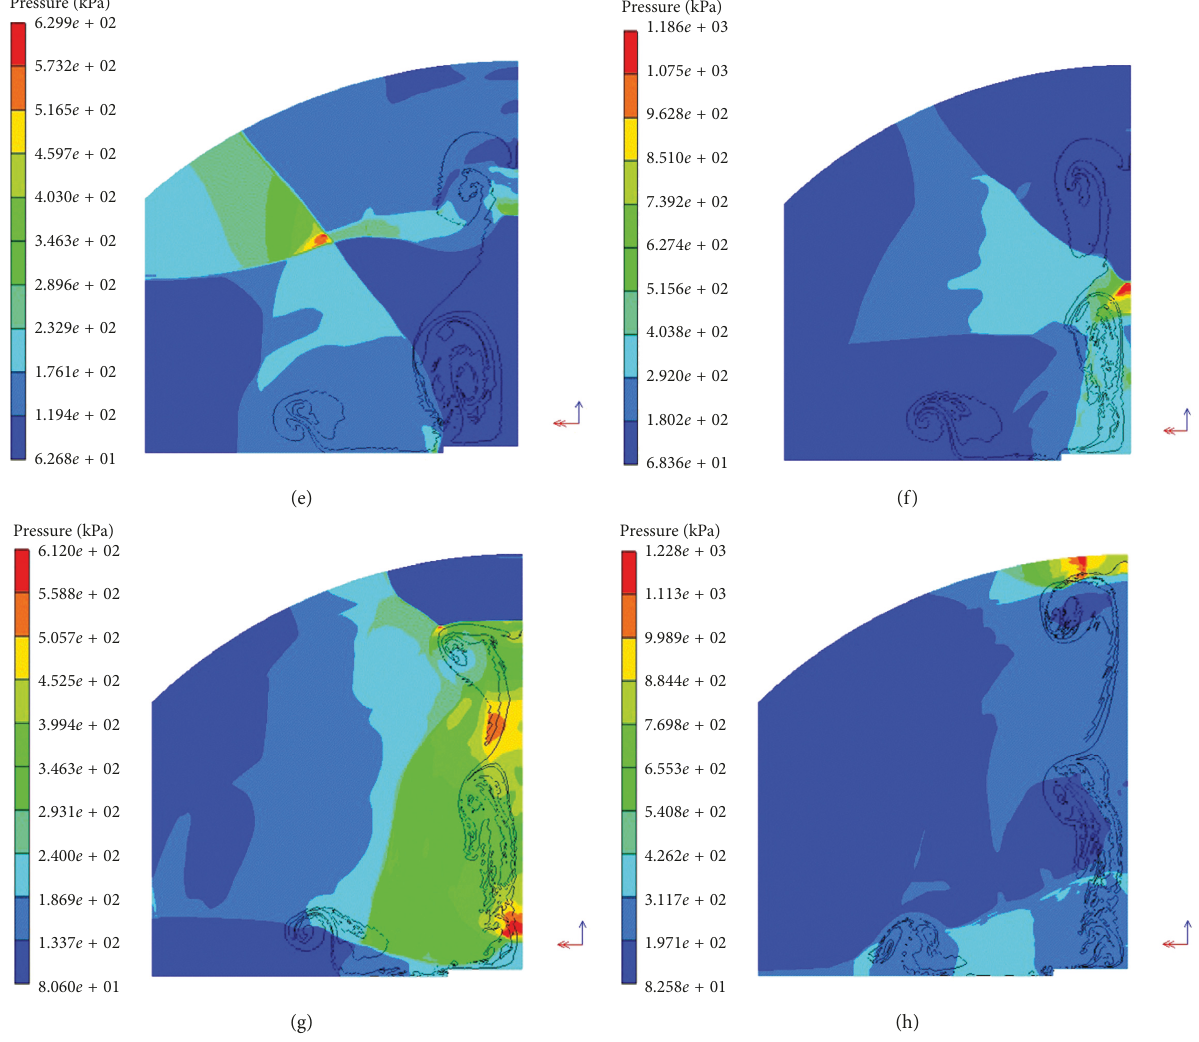
Figure 14: Evolution of pressure field in curved structure. (a) 0.1ms. (b) 0.3 ms. (c) 0.5ms. (d) 0.7ms. (e) 1.0 ms. (f) 1.2ms. (g) 1.4ms. (h) 1.6